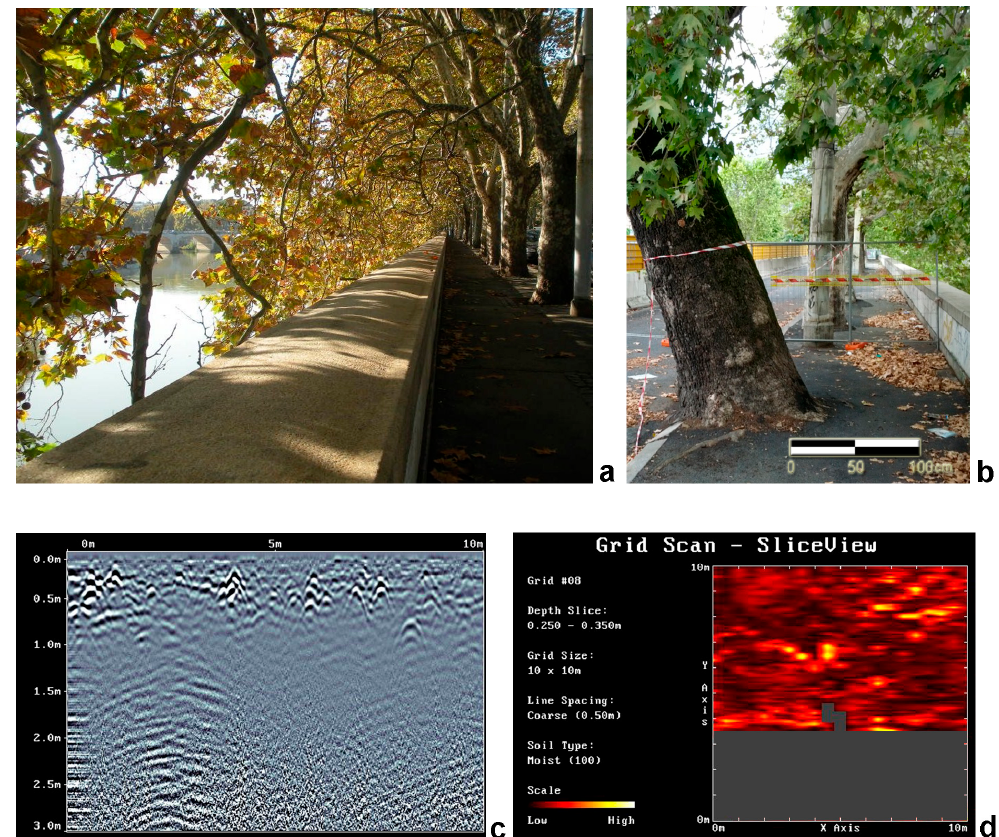
Figure 7. The upper images illustrate the critical situation of the plane trees between the embankments of the Tiber River and Lungotevere Street ( a , b ). The lower images illustrate the GPR results collected around the leaning tree ( c , d ) and highlight critical conditions in the first 0.3 m beneath the pavement. Note that the grey area in (d) represents the area with no GPR data parallel to the embankment.